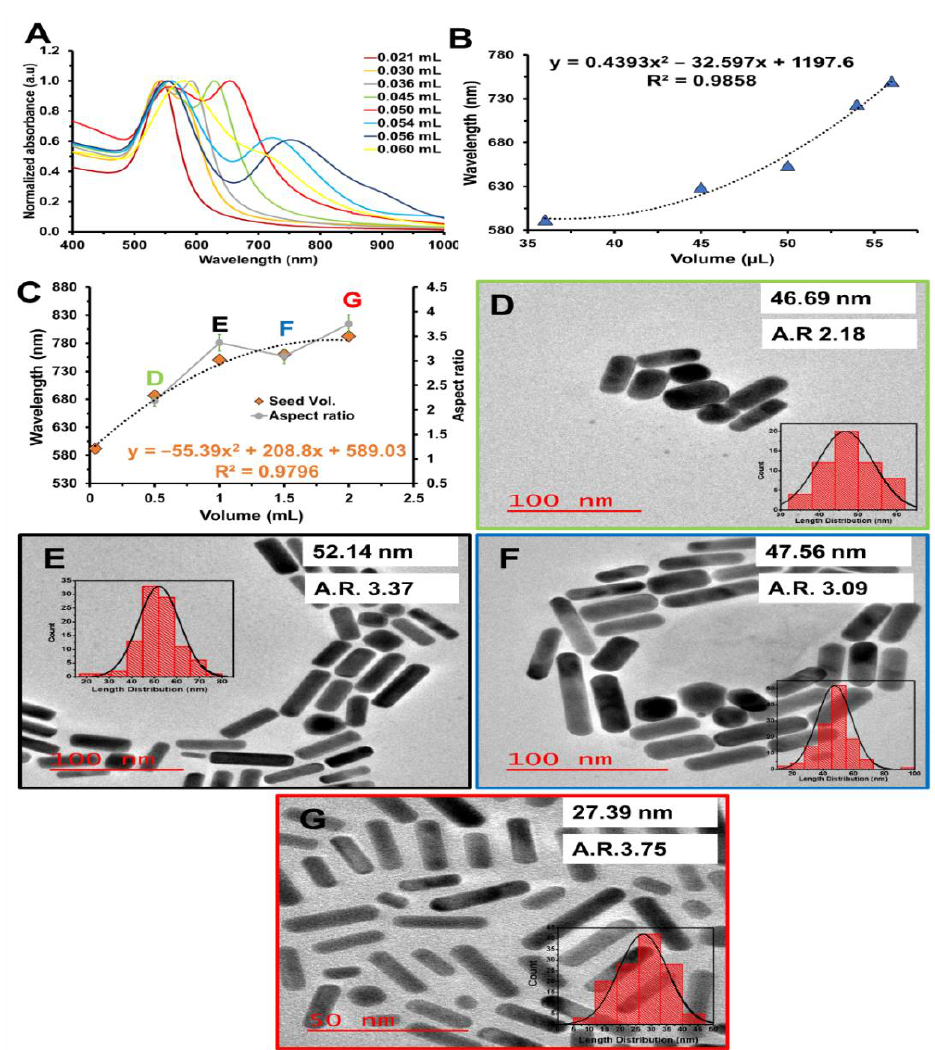
Figure 2. ( A ) Normalized UV-Vis-NIR spectra of AuNRs at different HCl volumes ( B ) Second-order polynomial relationship between the HCl volume and the corresponding LSPR band wavelengths. ( C ) The relationship between the seed volume against the corresponding LSPR band wavelengths and aspect ratio. TEM image of AuNRs synthesis with ( D ) 0.5, ( E ) 1.0, ( F ) 1.5, and ( G ) 2 mL of seed solution, while other parameters were kept constant.